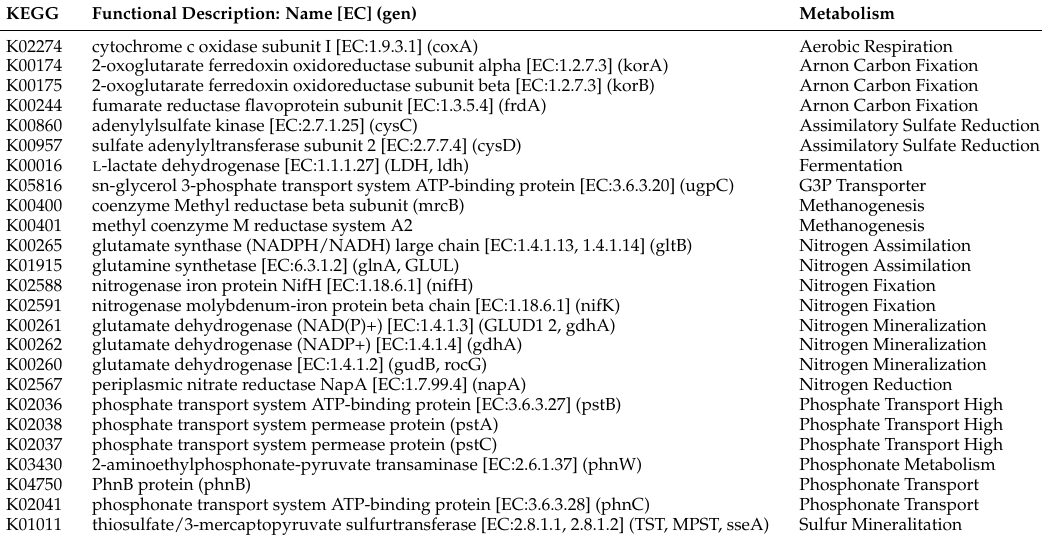
Table A2. KEGG’s table.